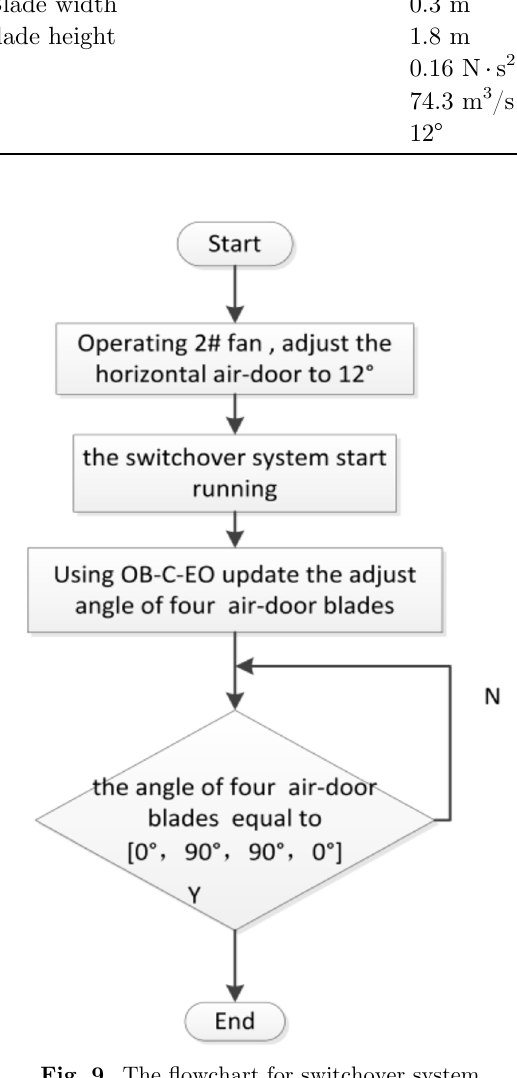
Fig. 9. The fl owchart for switchover system.